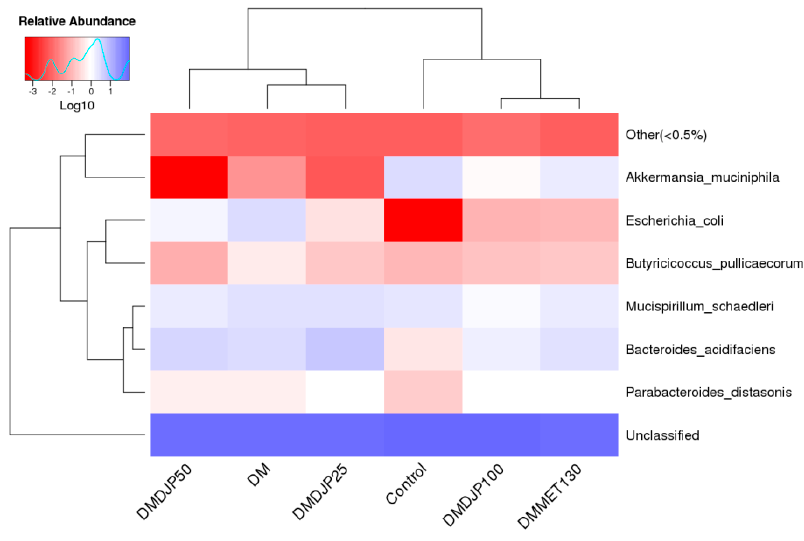
Figure 11. The heat map of species-level of the mice.